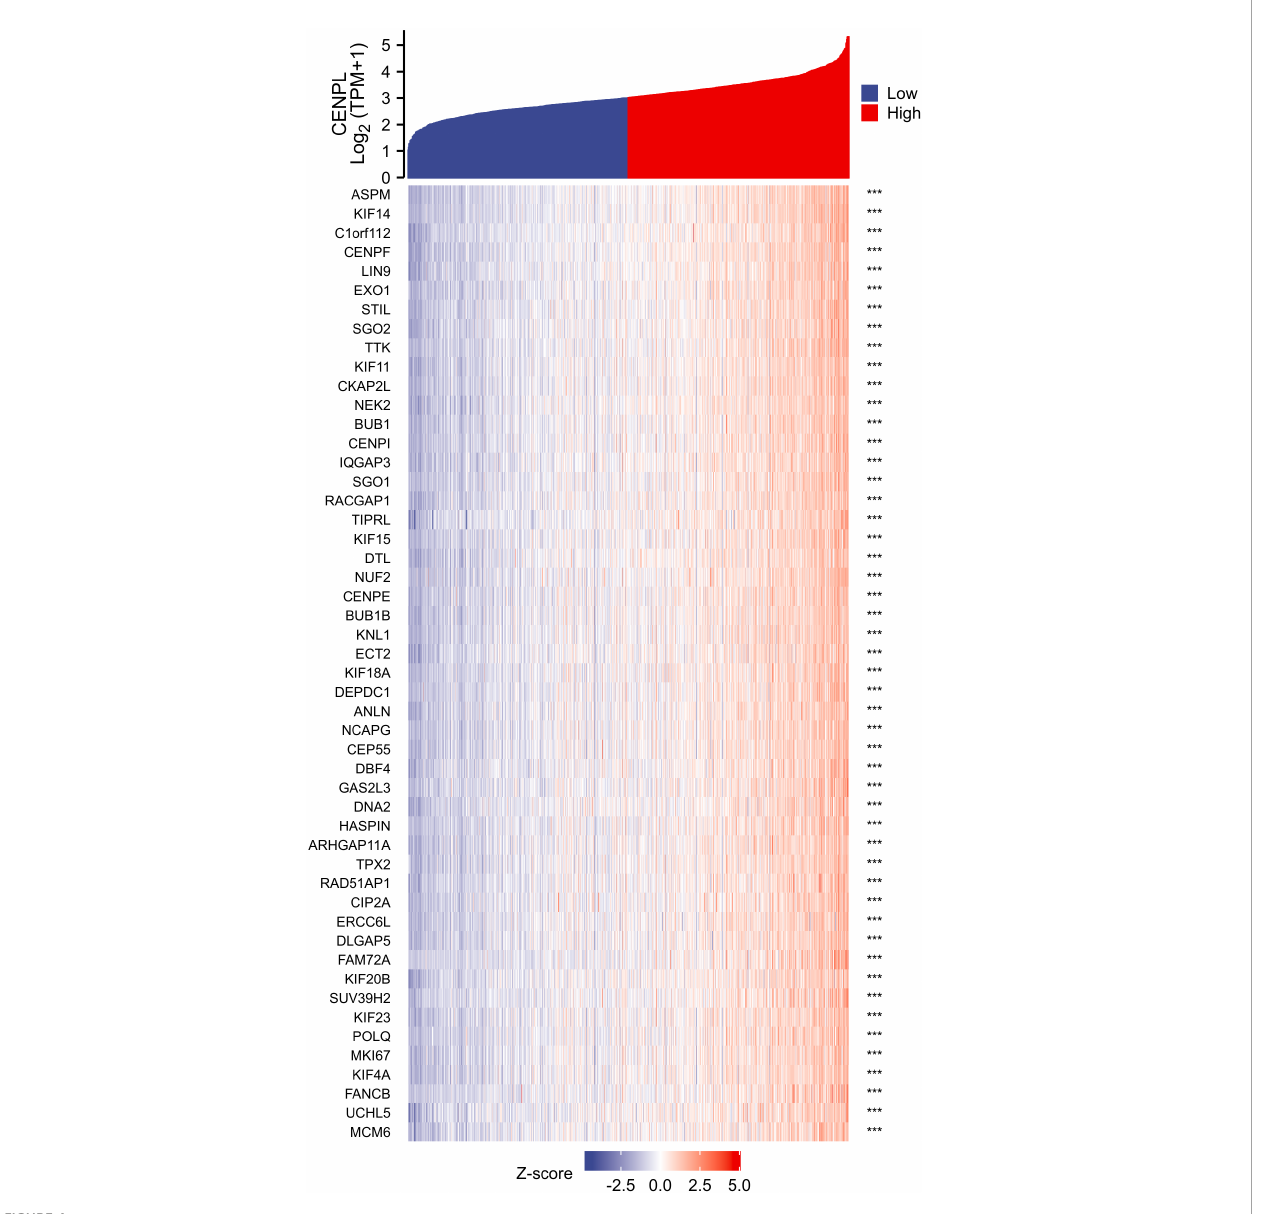
FIGURE 4 The 50 co-expressed genes with the highest positive correlation of